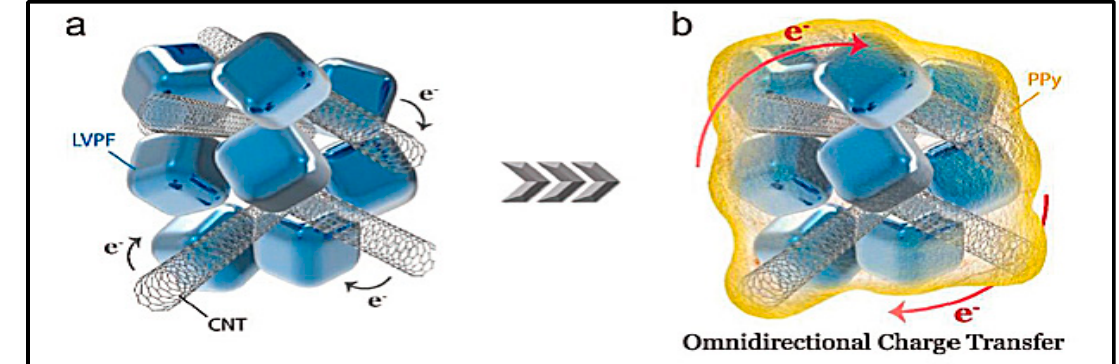
Figure 7. Schematic illustrations of ( a ) the CNTs networking for LVPF and ( b ) the CNTs networking + PPy coating for LVPF. Arrows indicate the efficient omnidirectional charge transfer. Reproduced with permission from [263]. Copyright 2019 Wiley.